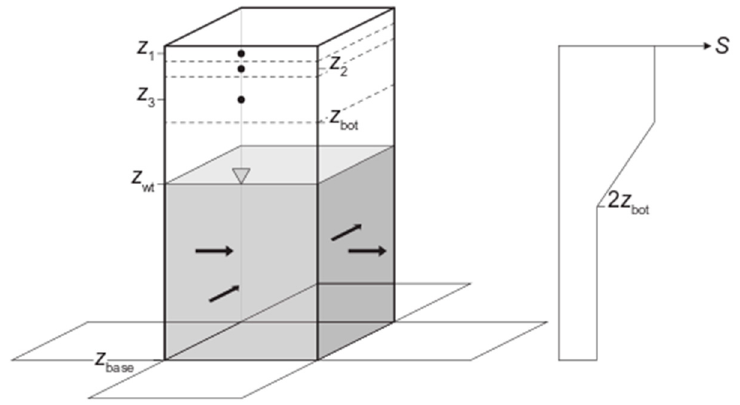
Figure 1. Layering in coupled soil-aquifer column and vertical variation in storage coefficient S . Z 1 , Z 2 , Z 3 are the node depths of the variable infiltration capacity (VIC) soil column, Z bot is the elevation of the bottom layer in VIC, Z wt the water table depth, and Z base the elevation of the base of the